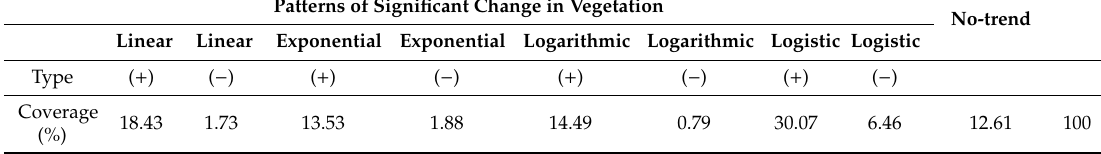
Table 2. Coverage of vegetation (NDVI max ≥ 0.2) change patterns in the Shiyang River Basin based on our framework. Each pattern is divided into two types according to the positive or negative trend in NDVI timeseries.